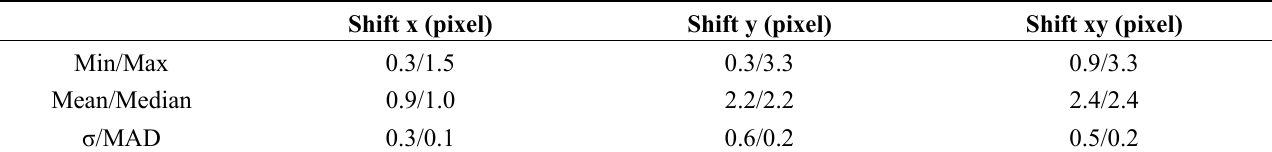
Table 4. Absolute accuracy evaluation; statistical summary from the shifts of 12:00 images acquired on 24 days in year